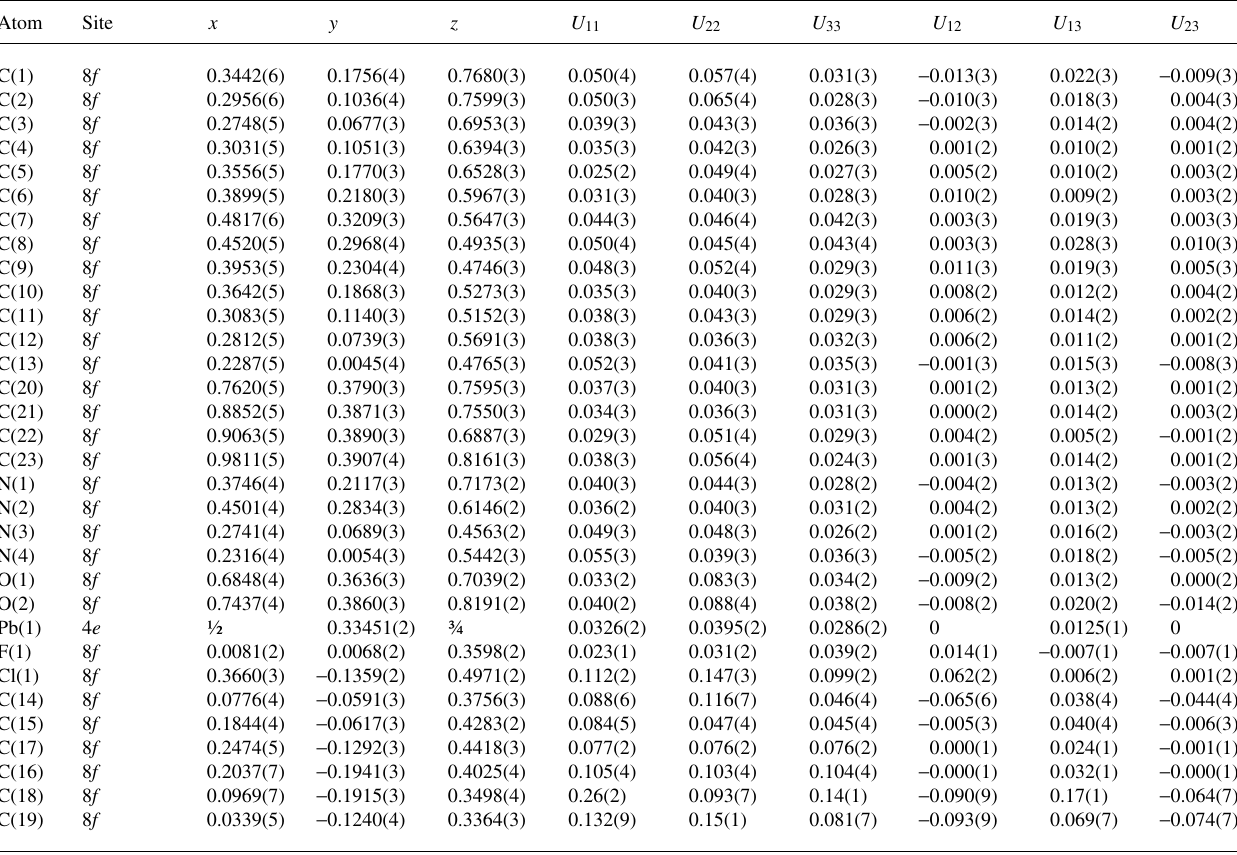
Table 3. Atomic coordinates and displacement parameters (in Å 2 )